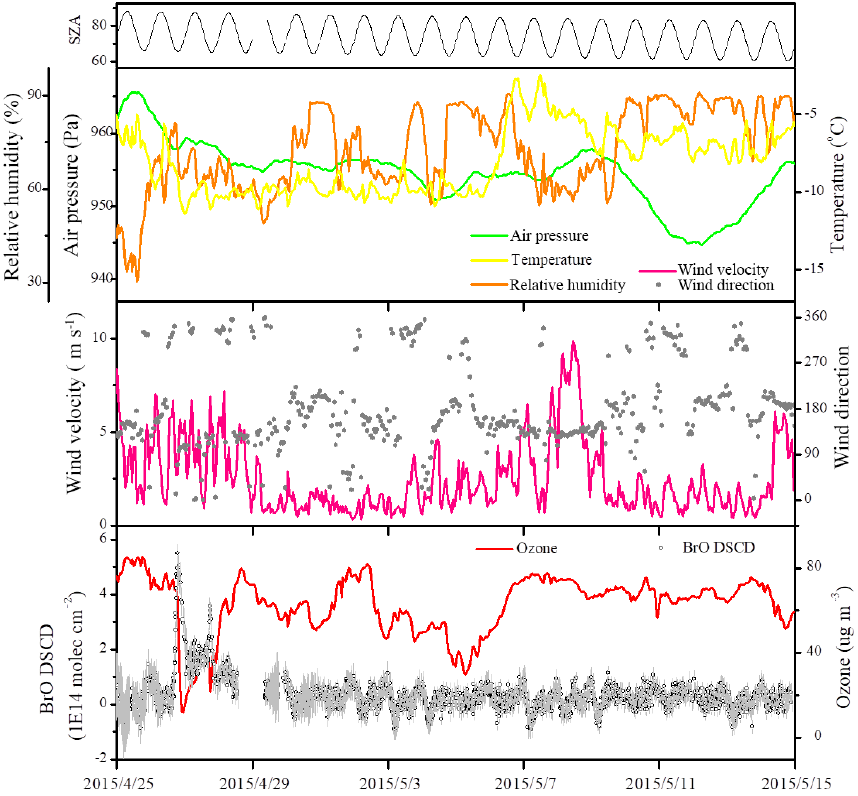
Figure 6. Time series of BrO DSCDs at 2 ◦ , surface ozone, solar zenith angle and meteorology data during the